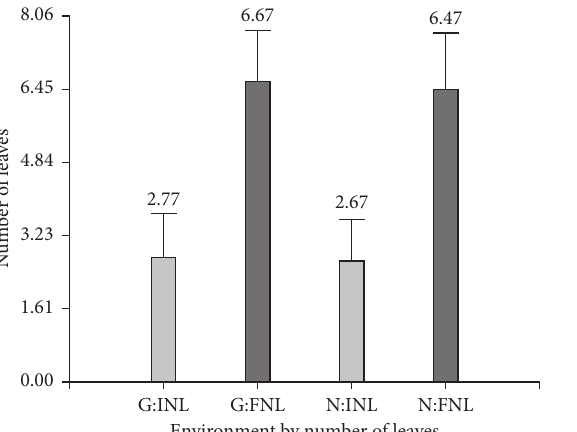
Figure 4: Number of total leaves/plant of coffee in nursery and greenhouse. G: greenhouse, N: nursery, INL: initial number of leaves, FNL: final number of leaves.